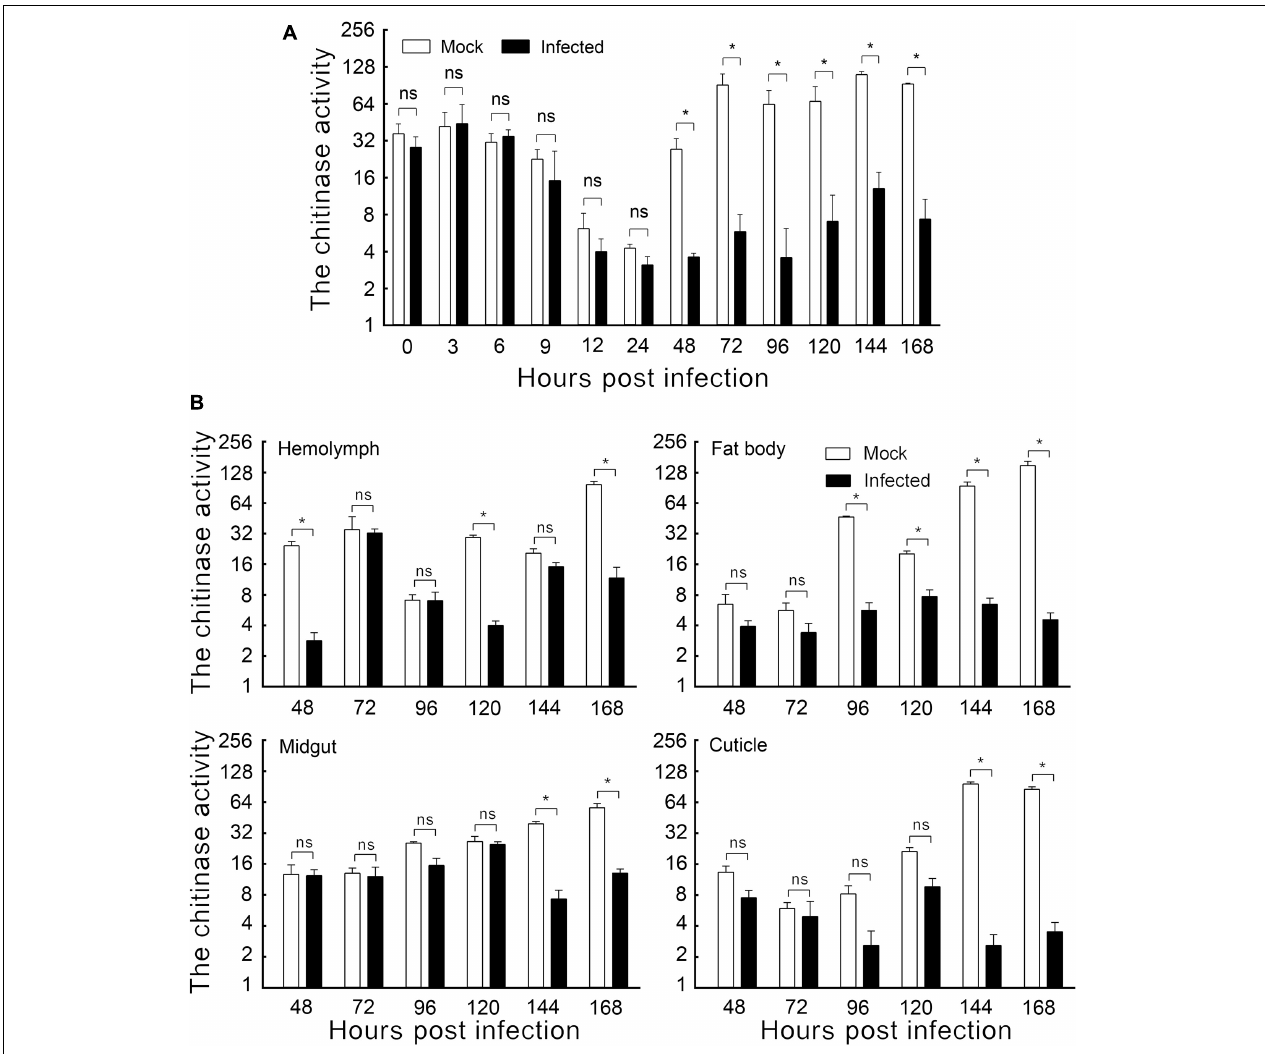
FIGURE 1 | The effect of HvAV-3h on chitinase activity in Spodopera exigua larvae. (A) Chitinase activity in the whole body. (B) Chitinase activity in different tissues. Mock, mock-infected larvae; Infected, infected larvae. * indicates significant difference between mock-infected and infected ( p < 0.05), ns indicates no difference between mock-infected and infected according to t